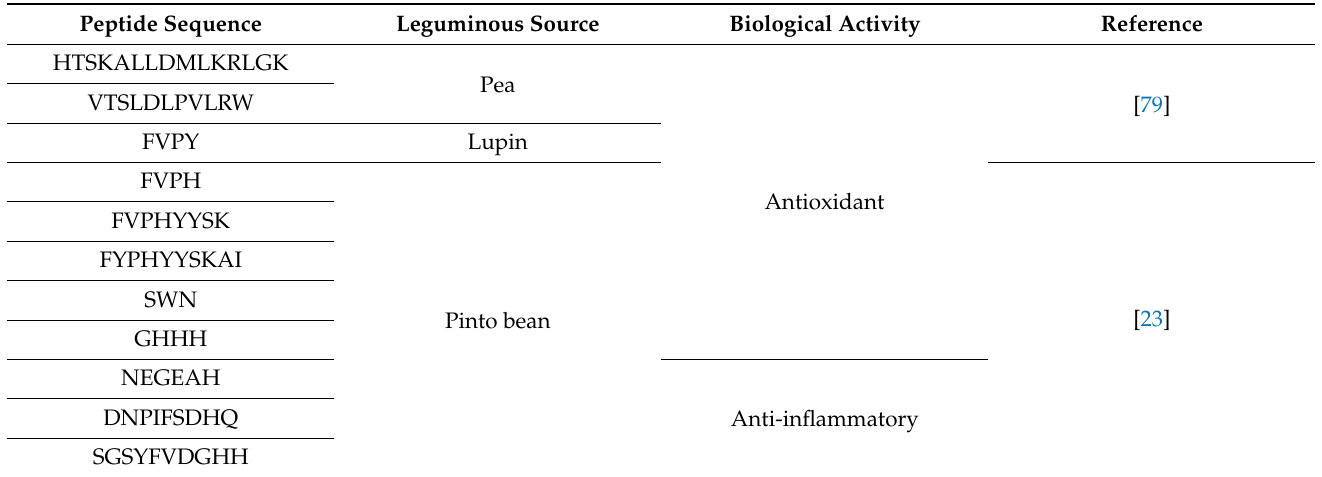
Table 2. Compilation of the peptide sequences with biological activities identified in different species of